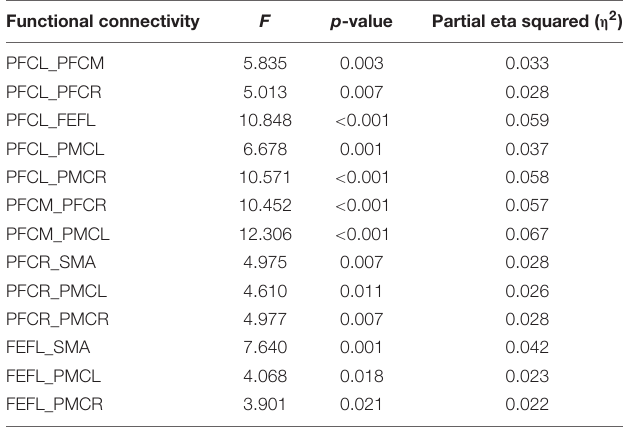
TABLE 2 | Functional connectivity with significant main effect of fatigue level in band frequency